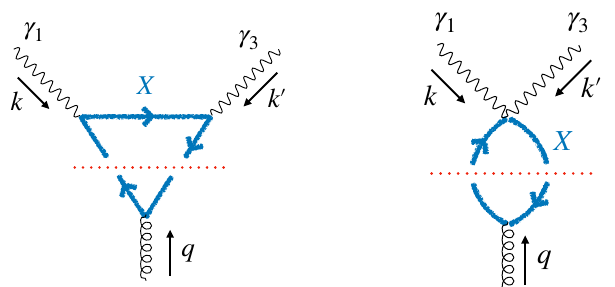
Figure 2 . Diagrams contributing to the 1-loop discontinuity of the 3-point function with k 2 = k 0 2 = 0 and q 2 > 4 m 2 (1–3 crossed triangle diagrams omitted for simplicity). Curly lines are graviton legs, X wiggle lines represent photons, charged particles of spin 0, 1/2 and 1 in the loop are represented by X = φ, ψ, W respectively, and dotted lines put legs that they cut